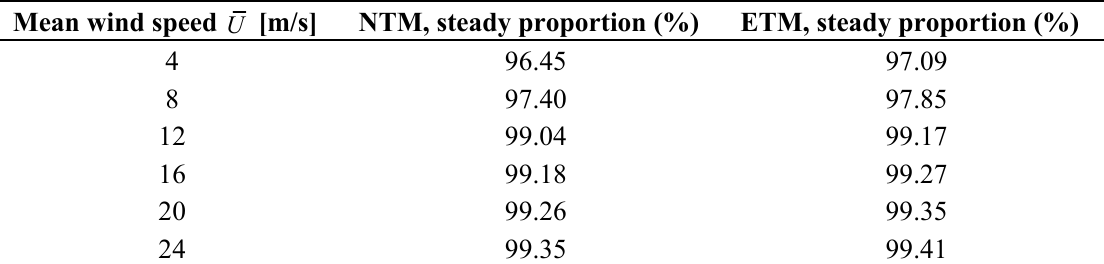
Table 2. Proportion of DTEF Spectrum in the Steady